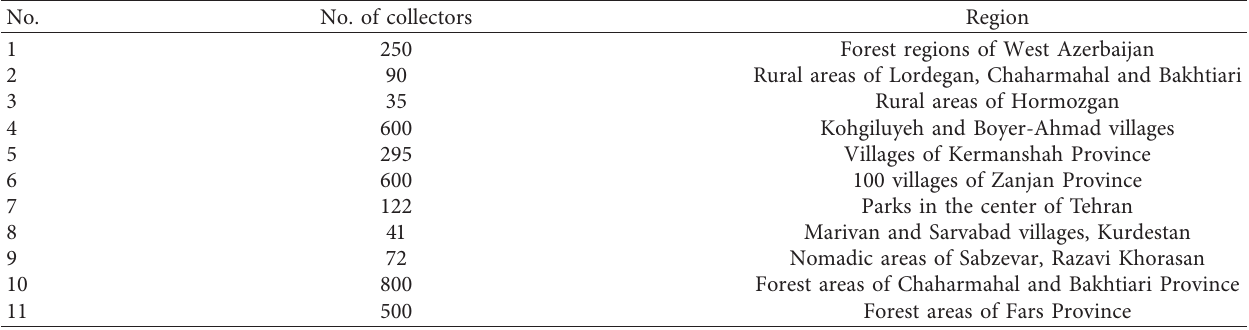
Table 1: SWH installation projects in the last two years in different regions of Iran [35, 36].